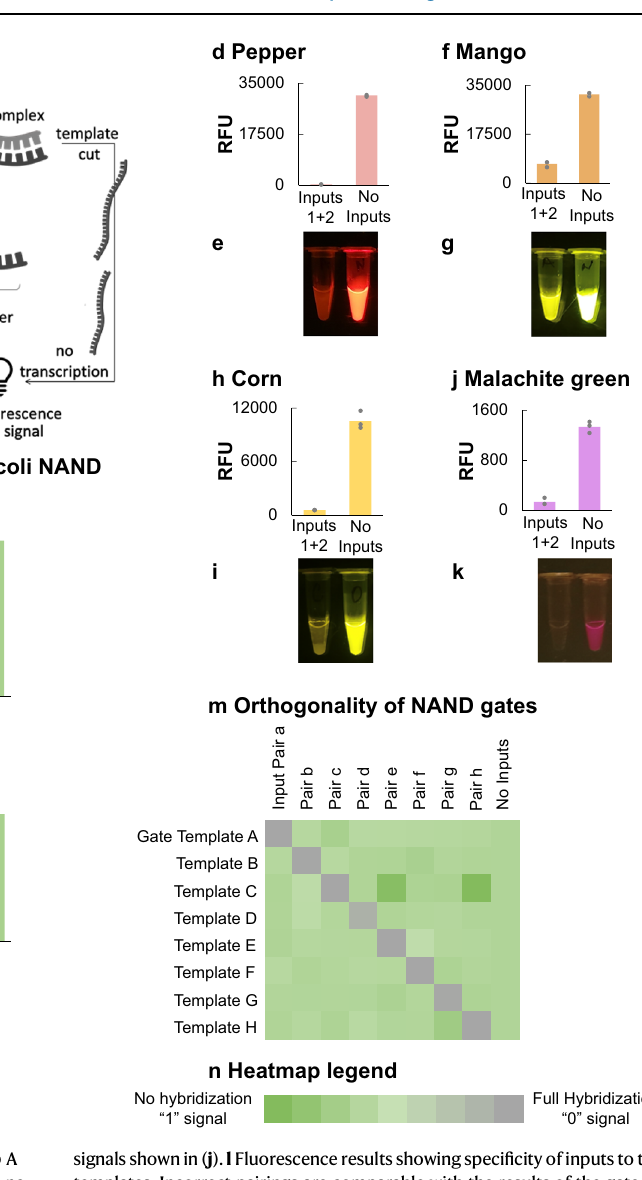
signalsshownin( j ). l Fluorescenceresultsshowingspeci fi cityofinputstotheirgate templates. Incorrect pairings are comparable with the results of the gate when no inputs are added, and the gate template remains intact. In contrast, when the correctpairofinputsismixedwiththegatetemplate,digestionoccurs,preventing the transcription of Broccoli, shown in the sample labeled “ Matching Inputs ” . correctly.Thedarkgraysquares represent 100% mismatch,orinputsthatare nota match to a gate template and will not hybridize. On all panels, the value of